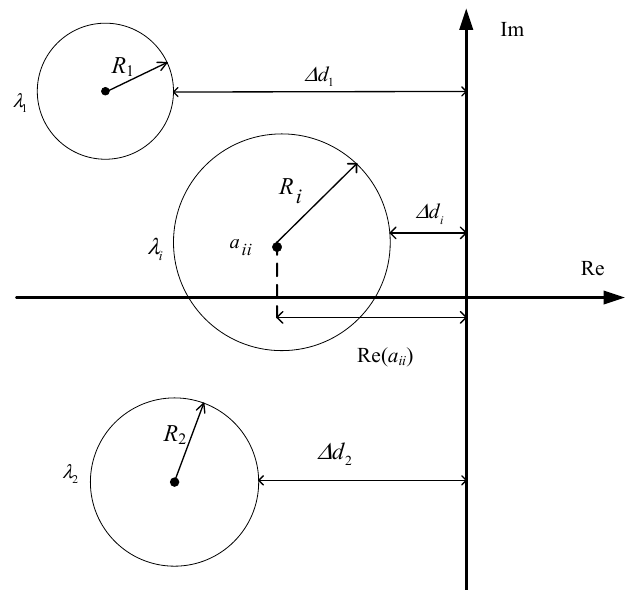
Figure 1. Gerschgorin disk theorem schematic.